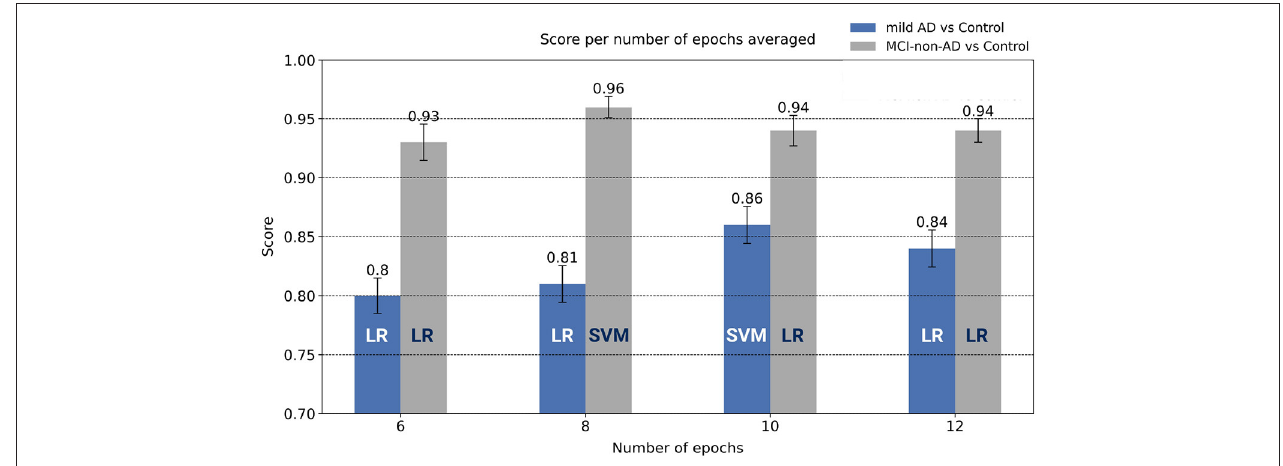
FIGURE 4 | Comparison of the results yielded for the two binary classification problems as a function of the number of epochs averaged during processing. Error bars indicate the standard error of the mean. For each case, we have also included the name of the best performing classifier. For the mild AD vs. Control problem and the MCI-non-AD vs. Control problem, SVM with 10 and 8 epochs used for the average, yielded the best performance,